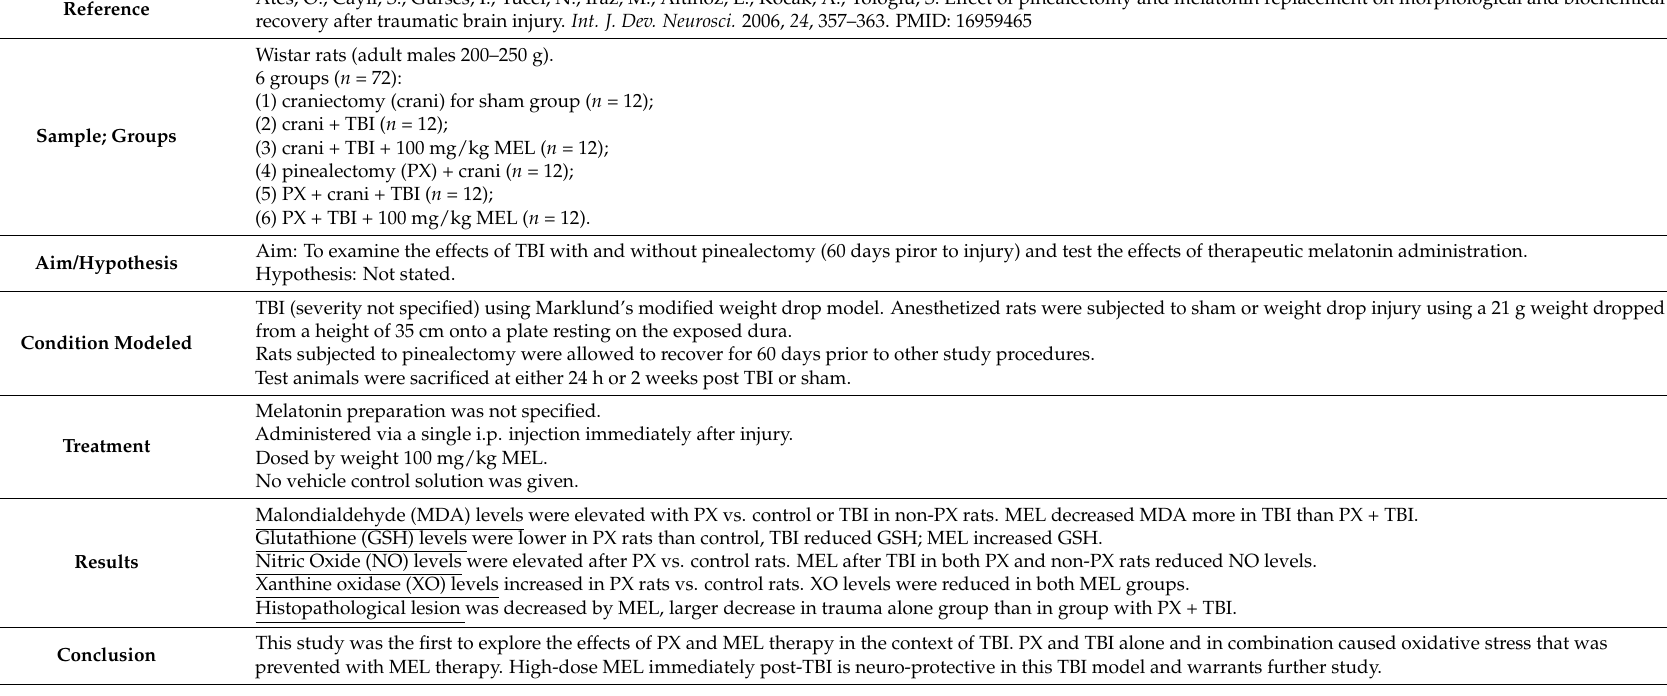
Table A8. Ates et al. (2006) Study